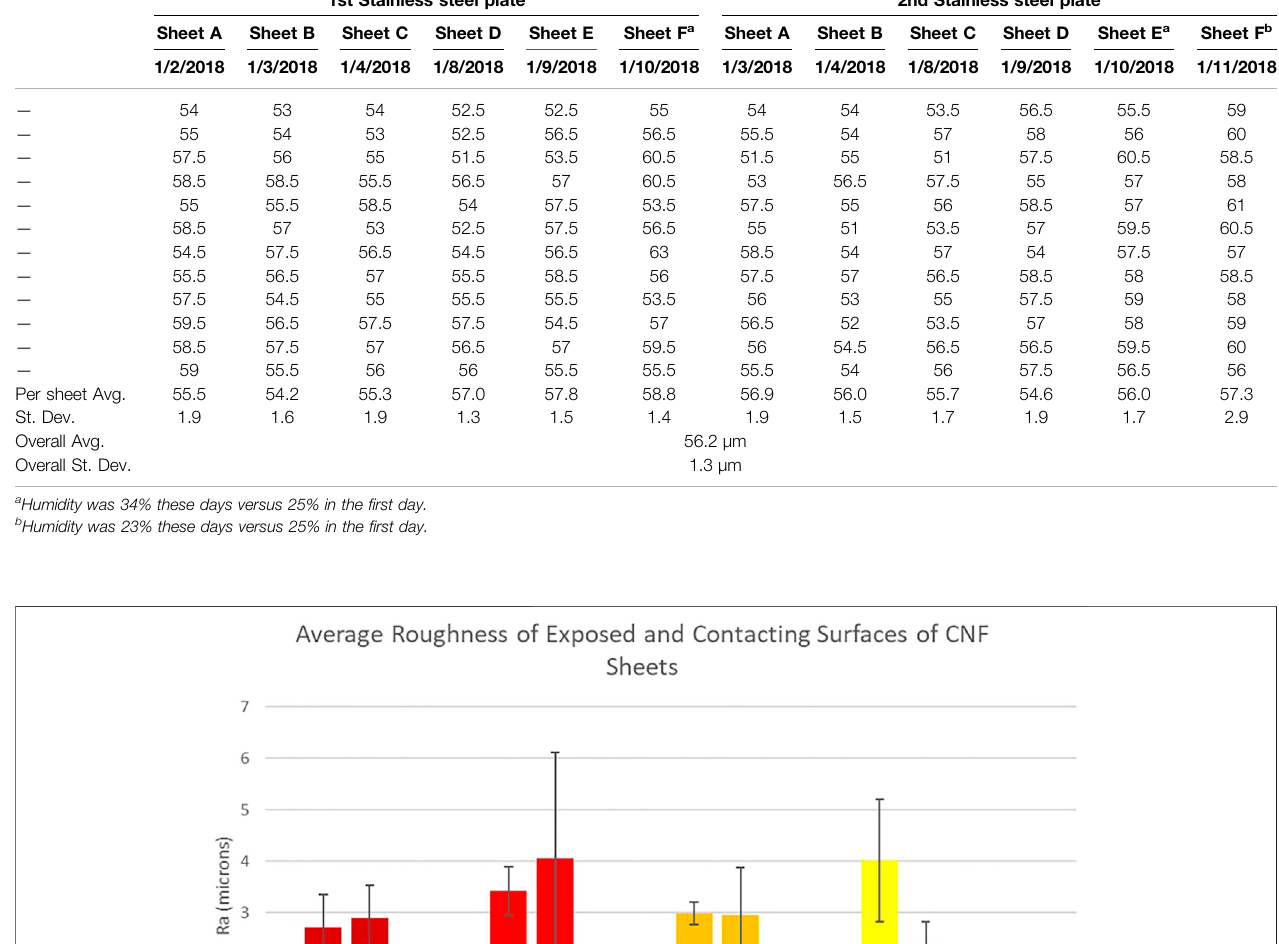
Frontiers in Nanotechnology |